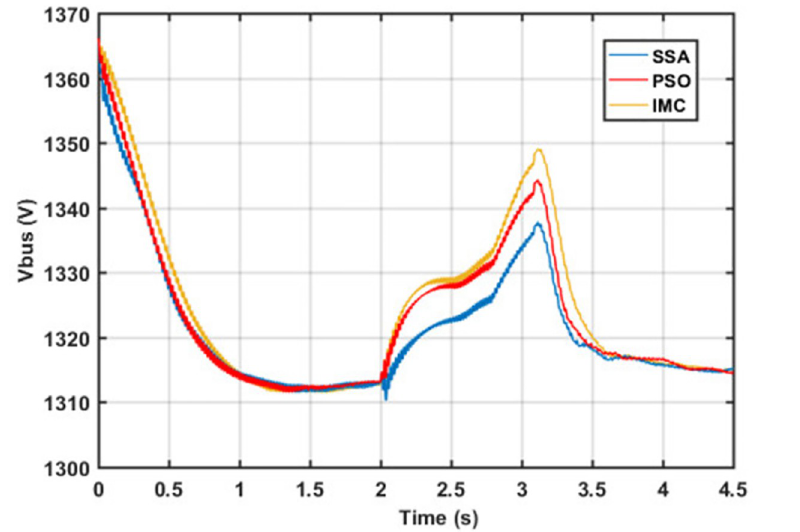
Fig 15. DC bus voltage response.